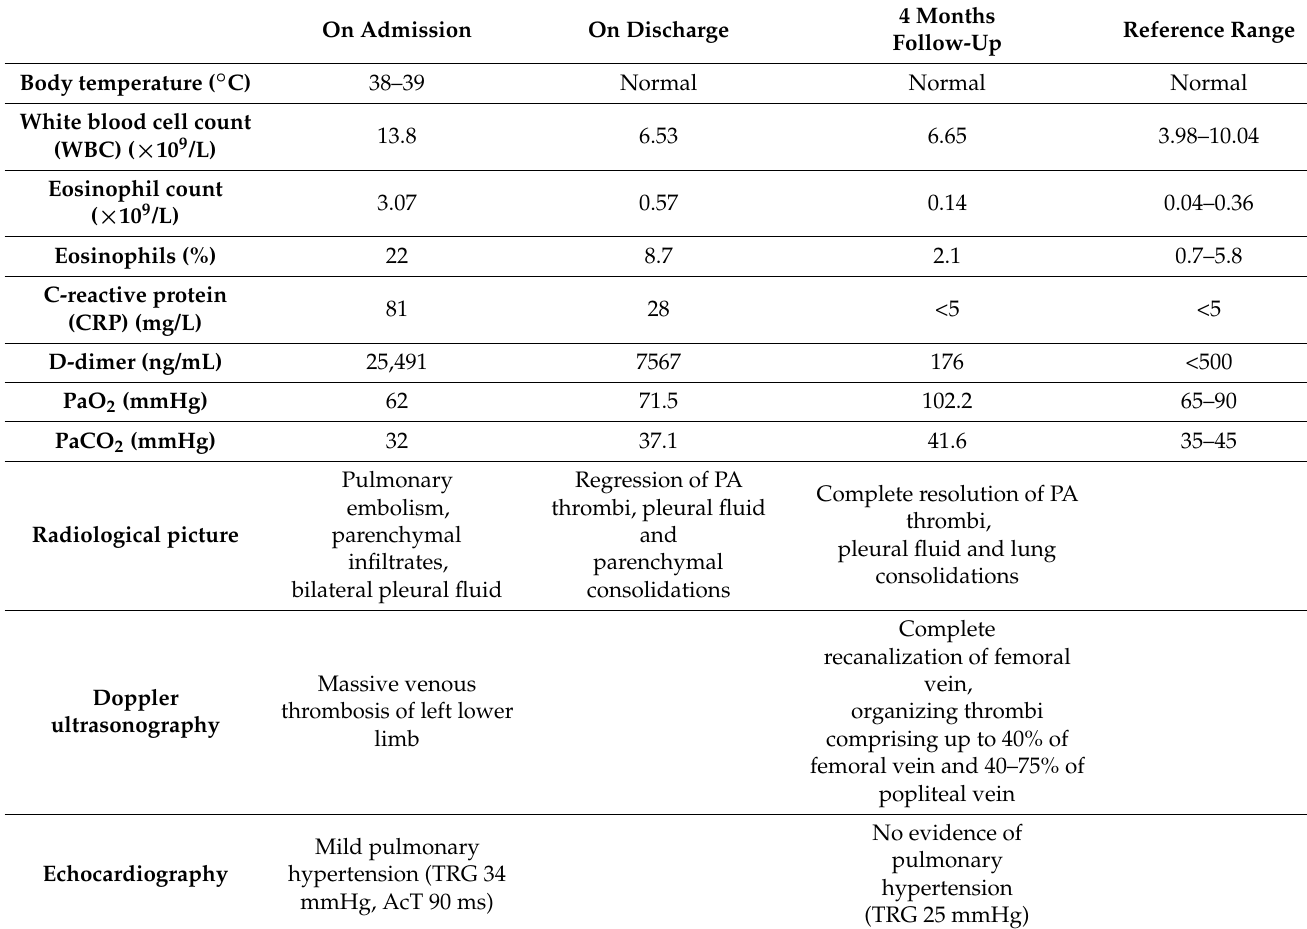
Figure 2. Computed tomography pulmonary angiography (CTPA) scan showing massive right pulmonary artery embolism (white arrows) ( a ), high resolution computed tomography (HRCT) of the chest showing ground glass opacities in the right upper lobe (white arrow), and left-sided pleural effusion (black arrow) ( b ). Table 1. Patient’s blood and imaging tests on admission, on discharge, and after four months